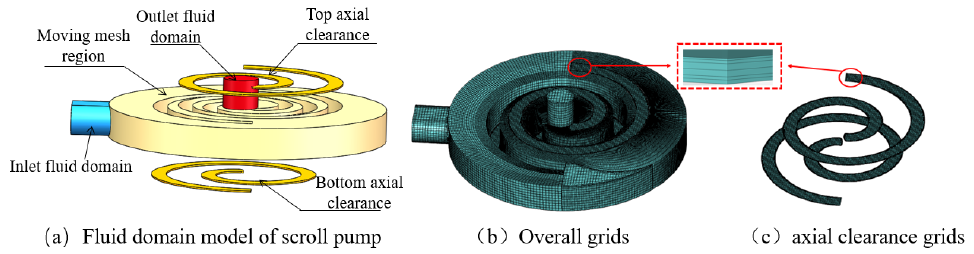
Figure 4. Fluid domain and grids of scroll pump.